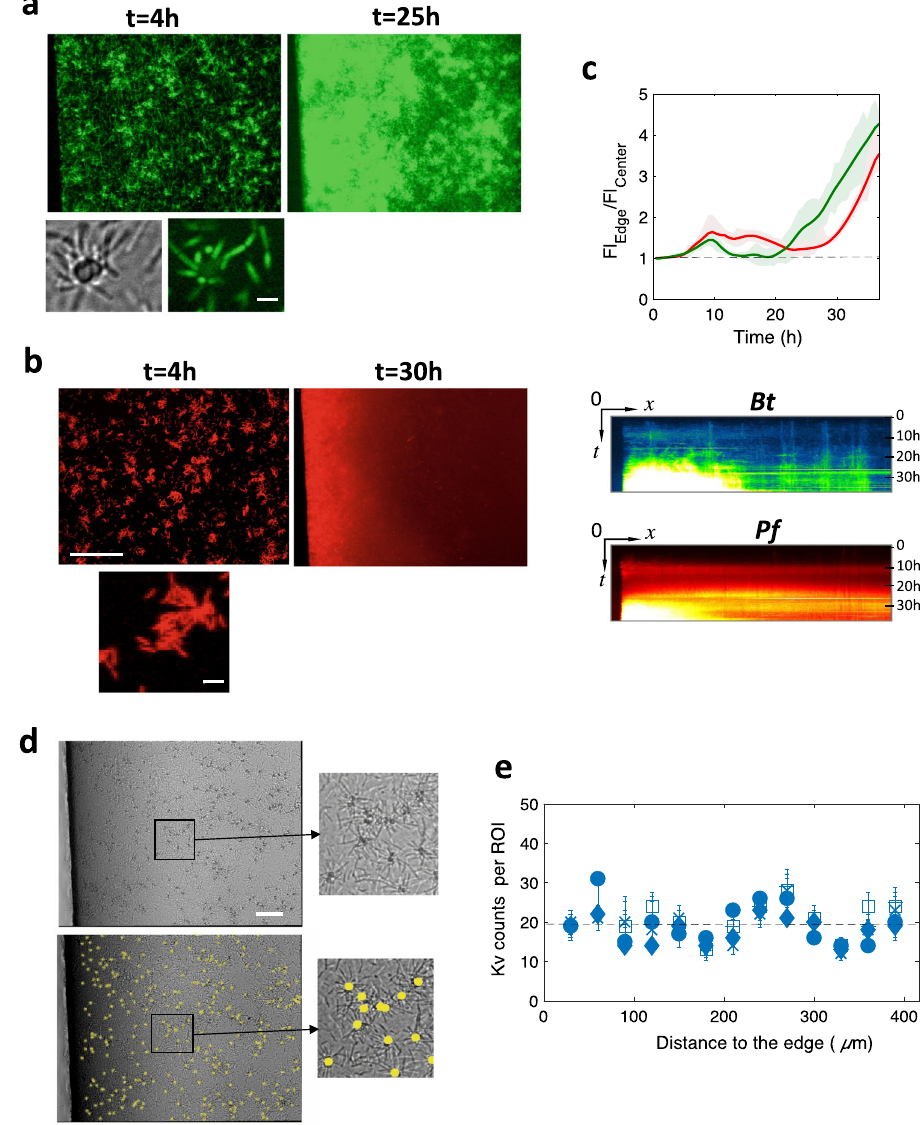
zoomed-in details showing local heterogeneities of the globally uniform distribution in the initial colonization phase; scale bars represent 5 µm. Graph of the ratio as a function of the fl uorescence intensity time at the channel edge (Fl edge ) to that at the channel center averaged on ROIs (20 µm wide) located at 20 and 360 µm from the channel wall, respectively; Bt in green and Pf in red ( c , upper panel). Kymographs of Bt (green blue) and Pf (Red) spatial distribution are presented ( c , lower panel). d Detection of Kv cells and clusters in the 4S bio fi lm using the NIS dark-spot detection tool (details provided in the Supplementary Note 3). Images correspond to time t = 14 h. In the bottom panel, the detection results are overlaid on the original image shown in the upper panel; scale bar is 50 μ m. e Kv spots were then counted in 30- μ m wide ROIs from the edge to the center of the channel for time t = 10 min ( ⎕ ); 20 min ( ● ); 7h30 (×); 6h30 ( ▢ ); and 32 h ( + ). Error bars report the error of 10% made on spot counts as evaluated by comparing automatic and visual